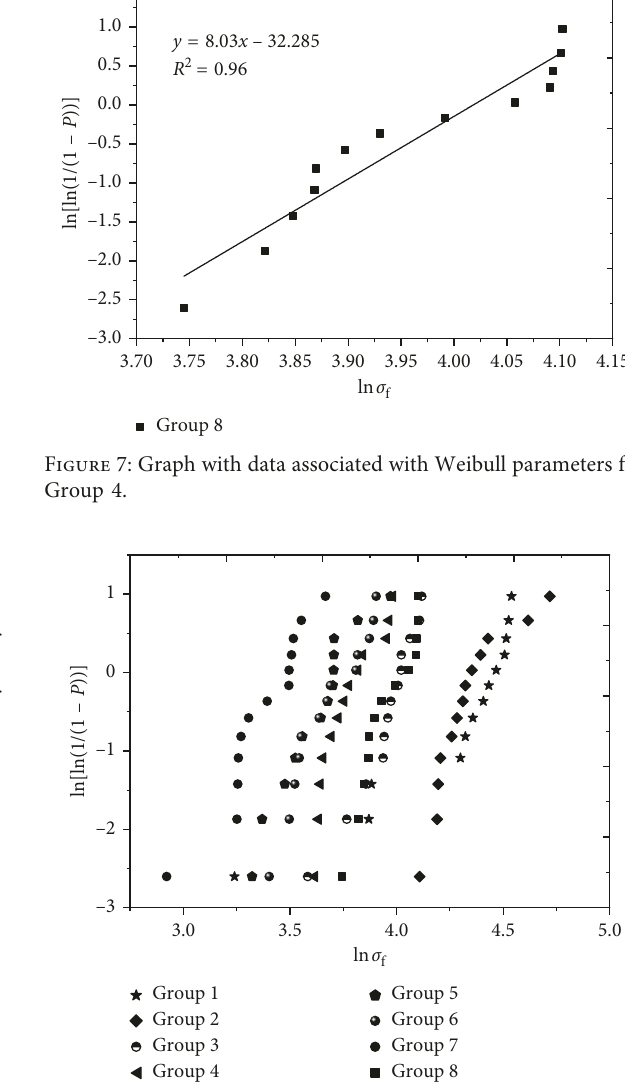
Figure 8: Graph with data associated with Weibull parameters for all